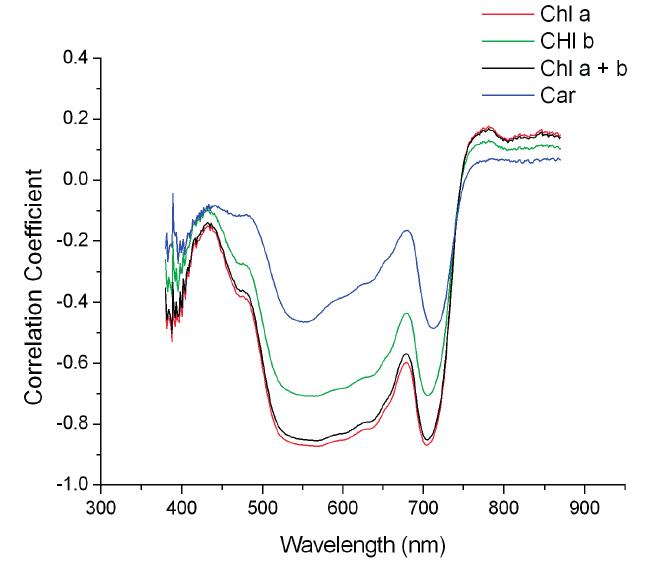
Figure 6. Correlogram of the mean spectral reflectance versus pigment content.